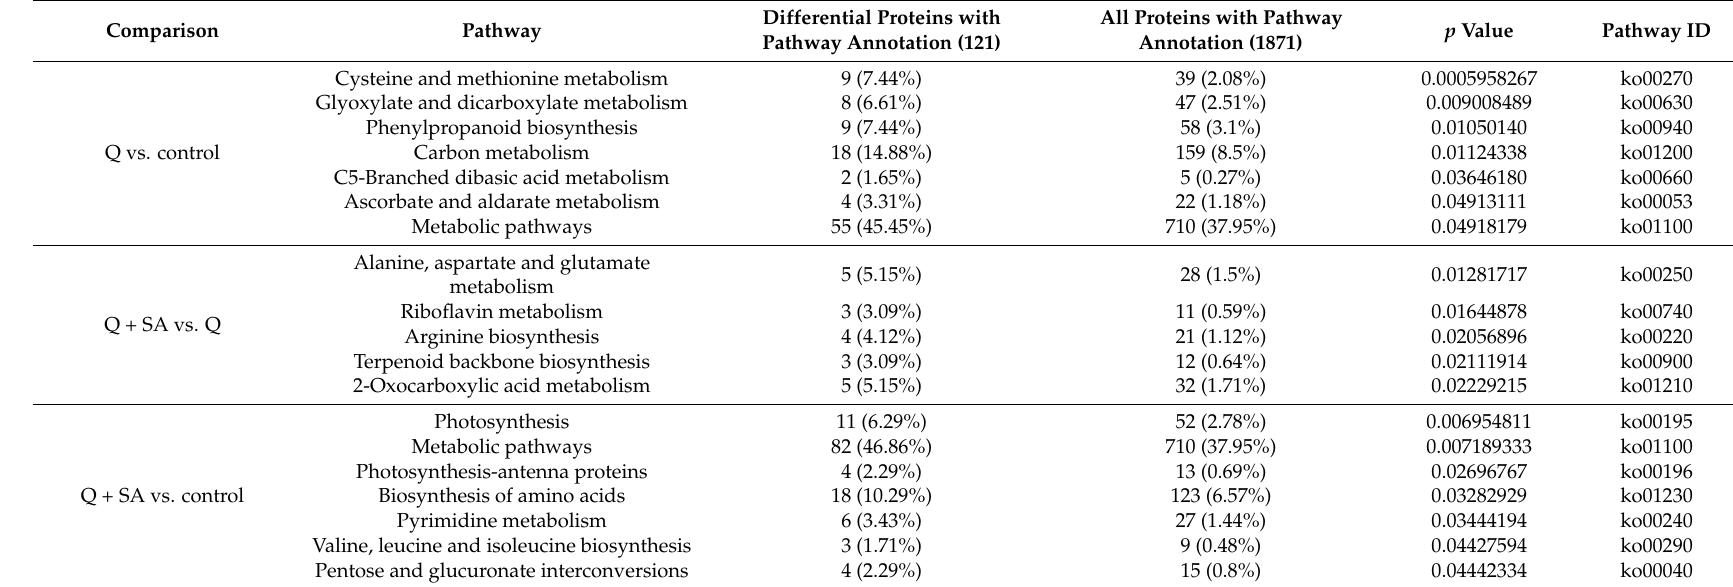
Table 2. The significant enrichment pathways with differential expressed